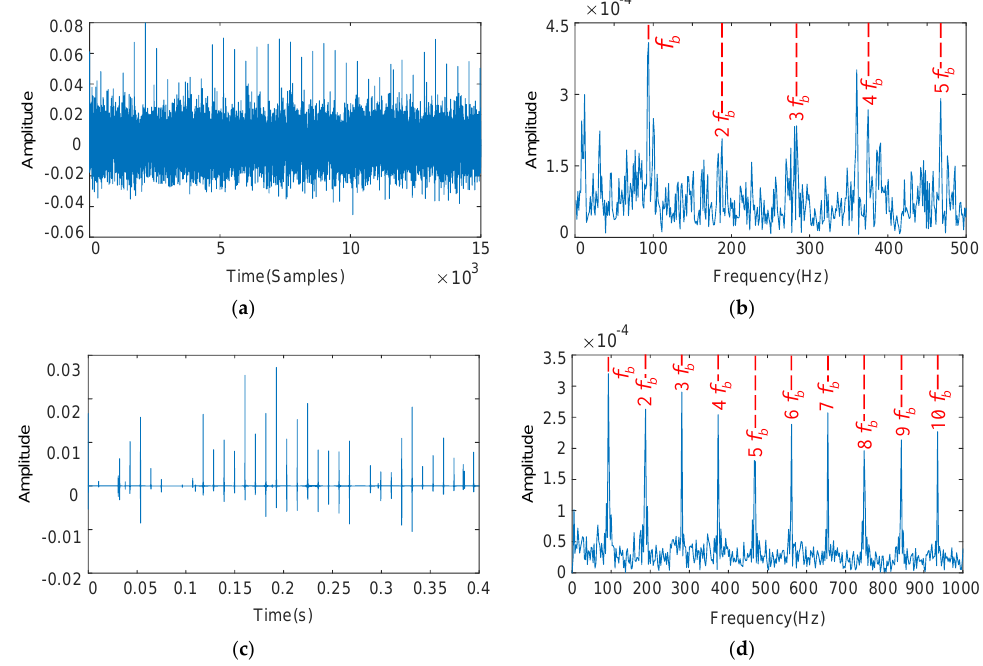
Figure 10. The decoupled bearing rollers vibration signal and its frequency spectrum: deconvolution results of MOMEDA: filtered time domain waveforms and their frequency spectrum ( a , b ); results obtained by MOMEDA and optimized RSSD: time domain waveforms and their frequency spectrum ( c , d ).